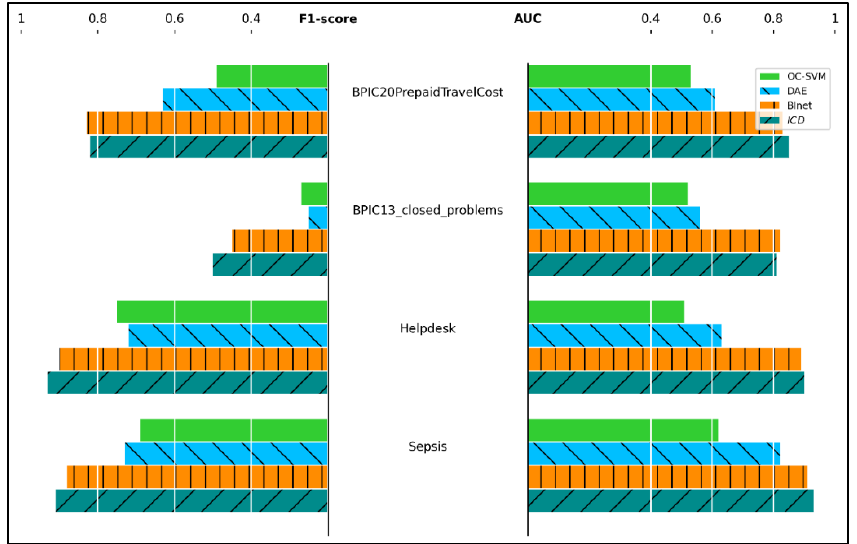
Figure 11. F1 score and AUC for all data sets in the detection